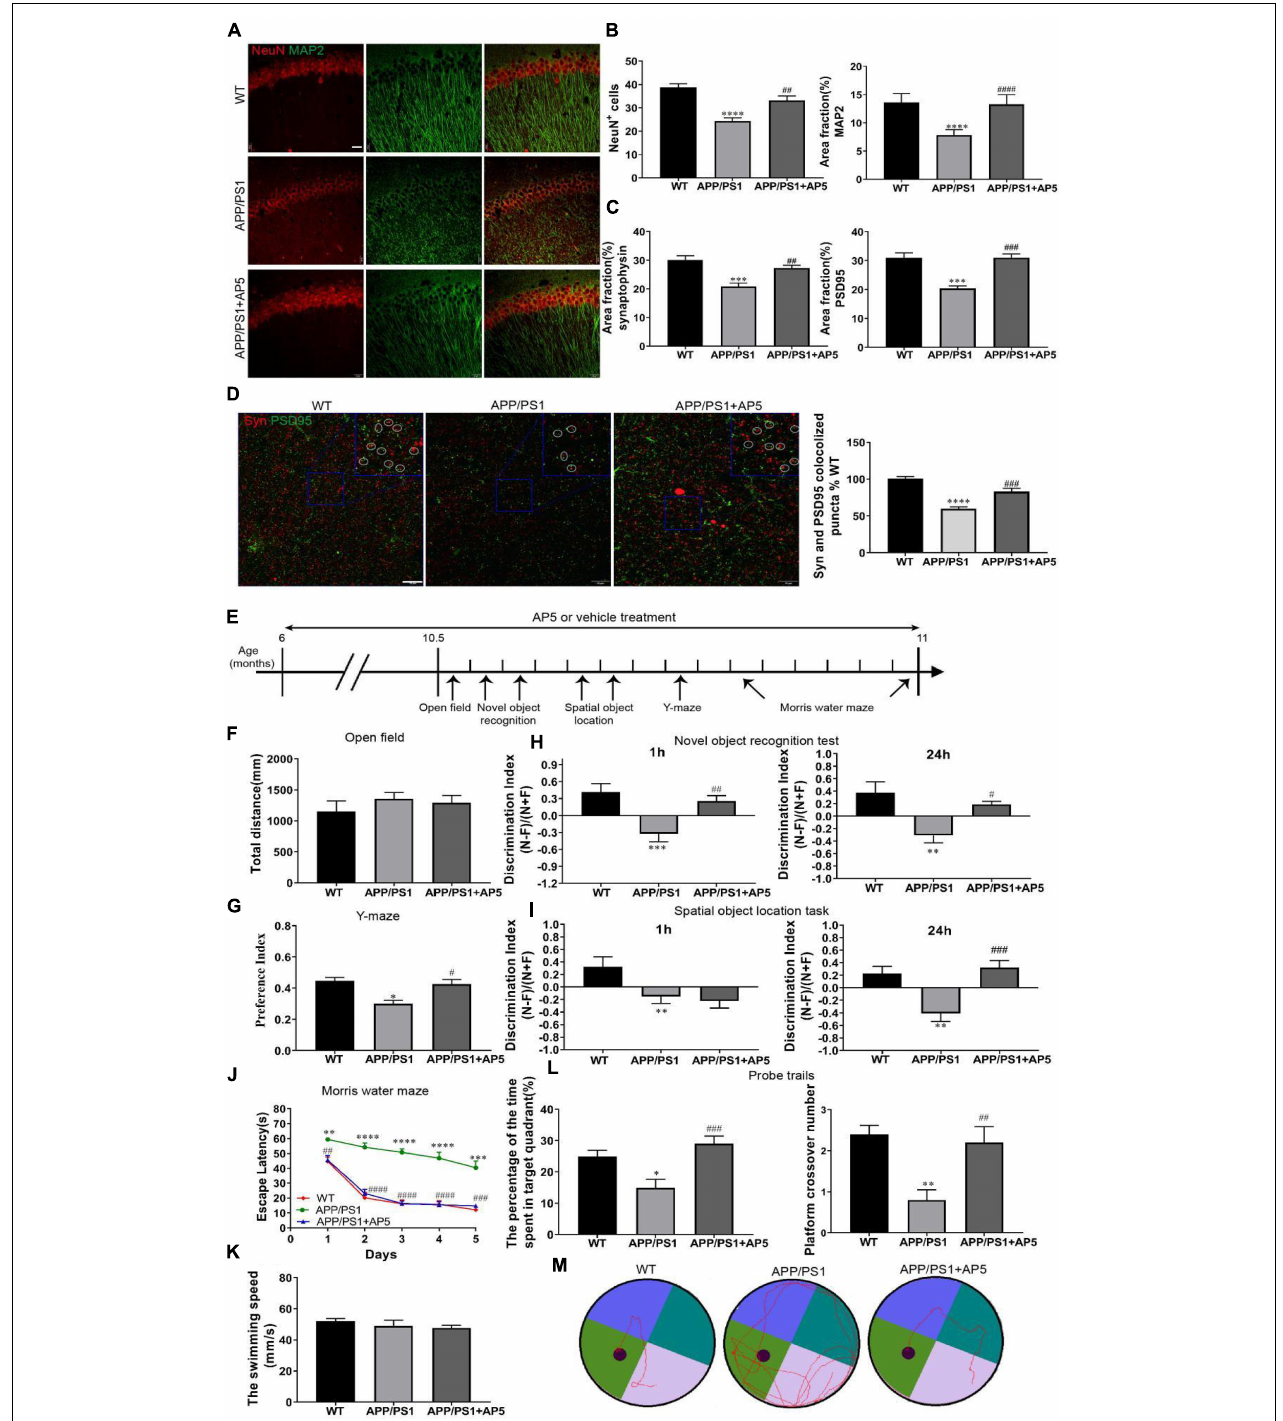
FIGURE 4 | AP5 restores neuronal and synaptic loss and improves cognitive deficits in APP/PS1 mice. (A) Representative fluorescent photomicrographs of NeuN, neuronal marker, and MAP2, dendritic marker, co-immunostaining in the CA1 region of hippocampus. Scale bar: 20 µ m. (B) Quantification of neuron survival by counting the average number of NeuN + cells and MAP2 fluorescence intensity in the CA1 pyramidal cell layer. (C) Representative fluorescent photomicrographs and quantification of synaptophysin (Syn) and PSD95 co-immunostaining in CA3 area of hippocampus. Scale bar: 10 µ m. Co-localized puncta are marked by circles. (D) Quantitative analysis of the Syn and PSD95 fluorescence intensity. ∗ P < 0.05, ∗∗∗ P < 0.001, ∗∗∗∗ P < 0.0001 compared with WT mice, # P < 0.05, ## P < 0.01, ### P < 0.001 by one-way ANOVA followed by a Turkey’s post hoc test, n = 6 mice per group. (E) The timeline of the various behavioral experimental